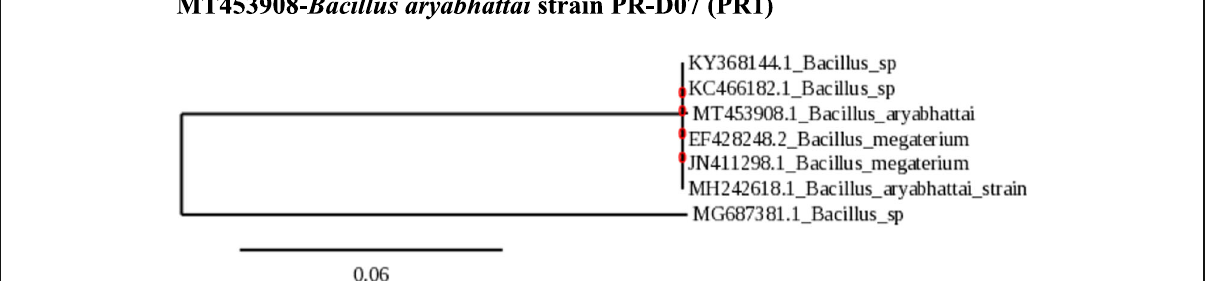
Fig. 1 Neighbor-joining tree showing the phylogenetic relationships of 16S rRNA gene sequences of B. aryabhattai . The scale bar indicates evolutionary